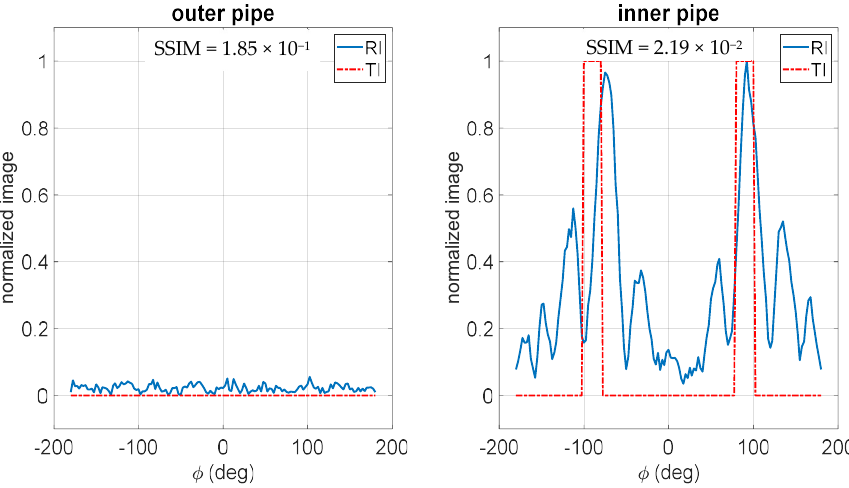
Figure 3. Reconstructed images of the reference case (RI: reconstructed image and TI: true image).